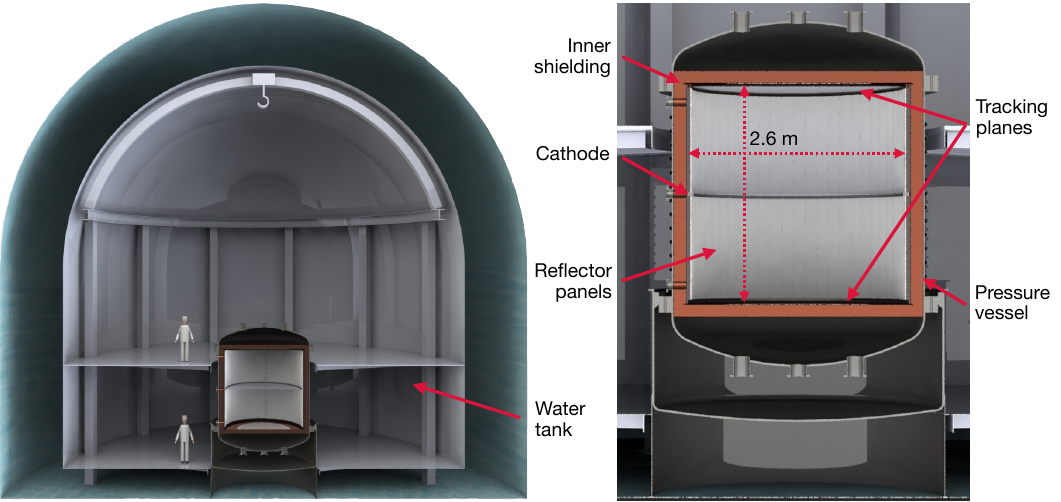
Figure 2 . Left: conceptual design of a tonne-scale NEXT detector installed inside a water tank. Right: detail of the internal structures of the detector. The active volume, 2 . 6 m in diameter and height, would hold a mass of 136 Xe of approximately 1109 kg at 15 bar